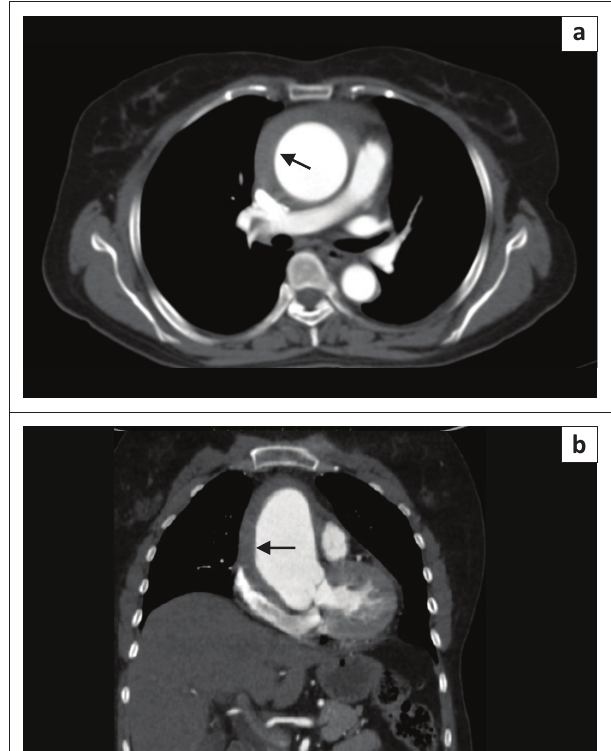
FIGURE 7: Type A intramural haematoma. Contrast-enhanced axial (a) and coronal (b) computed tomography scan showing a non-enhancing hypodense crescent-shaped area (arrow) compressing the normal contrast-enhanced aortic